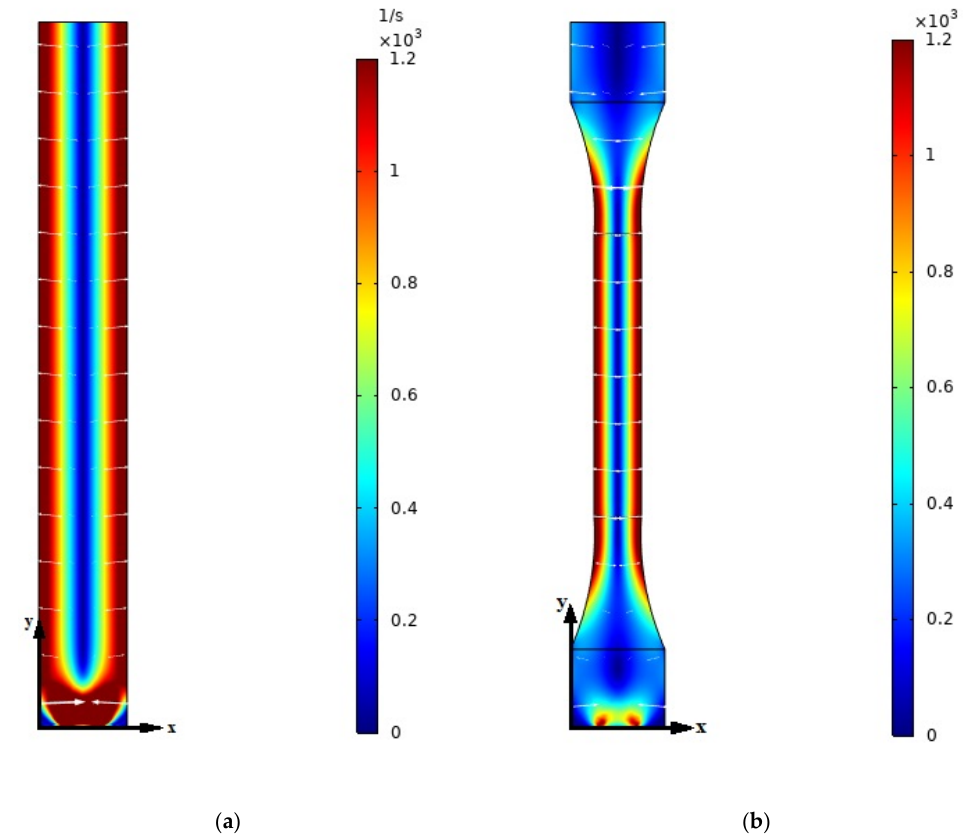
Figure 11. Strain rate and average GNP orientation for PA66 with 0.3 wt% GNP for ( a ) rectangular and ( b ) dog bone sample. Arrows represent the average GNPs’ axis orientation.